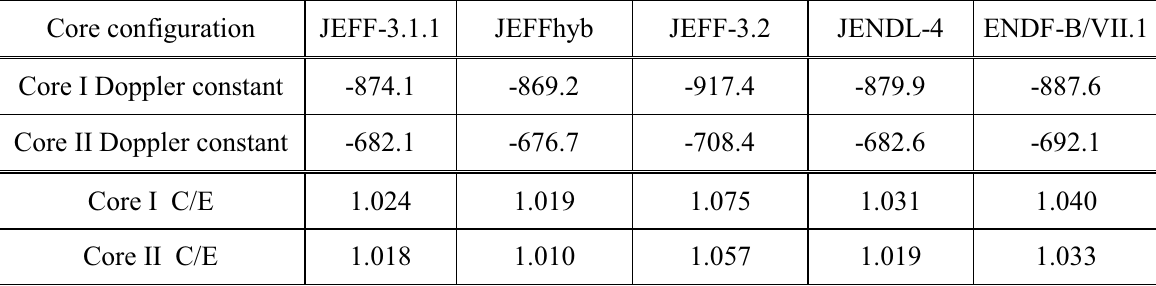
Table II. Calculated Doppler constants (pcm) and related C/E values for SEFOR Core I & II using different evaluated nuclear data libraries